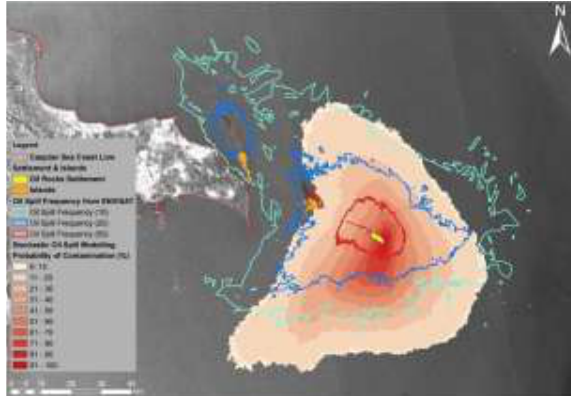
Figure 15. Oil spill frequencies and oil contamination probability around the Oil Rocks Settlement.